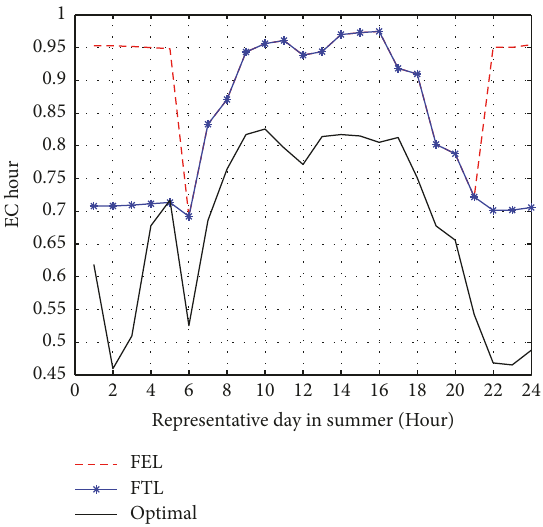
Figure 8: Comparison of three strategies in a summer day.